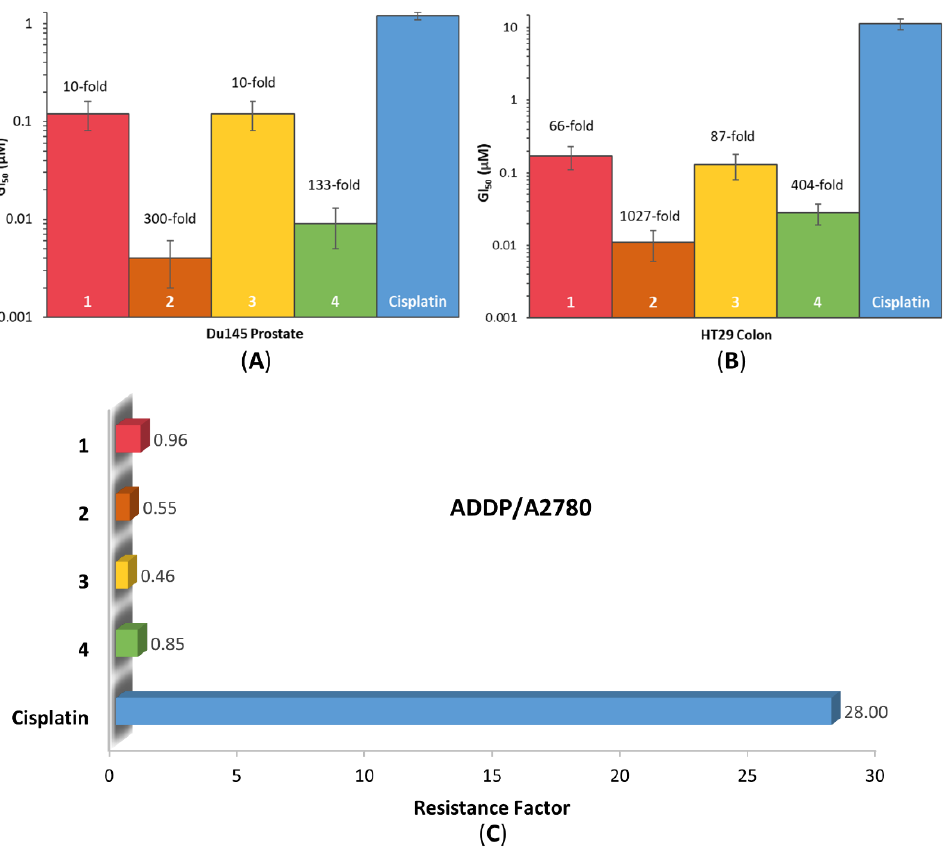
Figure 8. The GI 50 values of 1 – 4 and cisplatin in the Du145 Prostate ( A ) and HT29 colon ( B ) cancer cell lines with the number-fold potency of 1 – 4 against cisplatin. ( C ) The resistance factors (RF) of 1 – 4 and cisplatin toward ADDP (subclone of A2780) versus A2780 ovarian cancer cell lines. Complexes were incubated for 72 h. GI 50 values (µM) are the mean and reported with standard error of the mean; produced from three independent experiments.